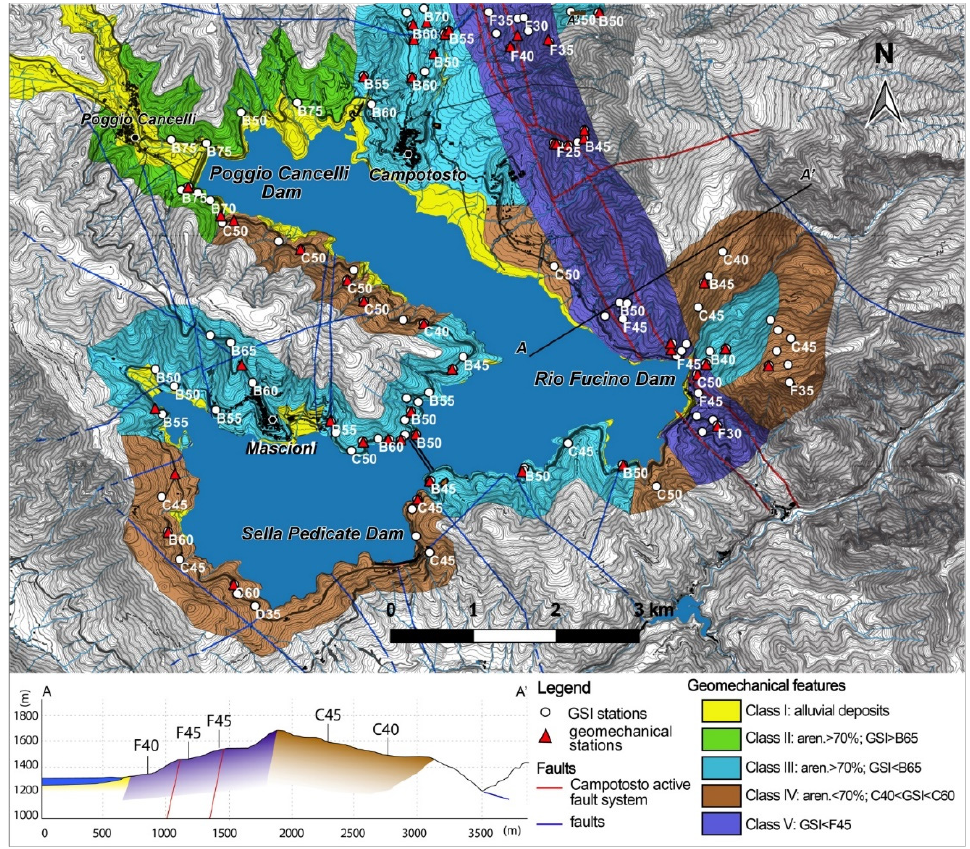
Figure 7. Map of the geomechanical features of the Lake Campotosto basin; section A–A’ across the active fault system in the bottom panel.